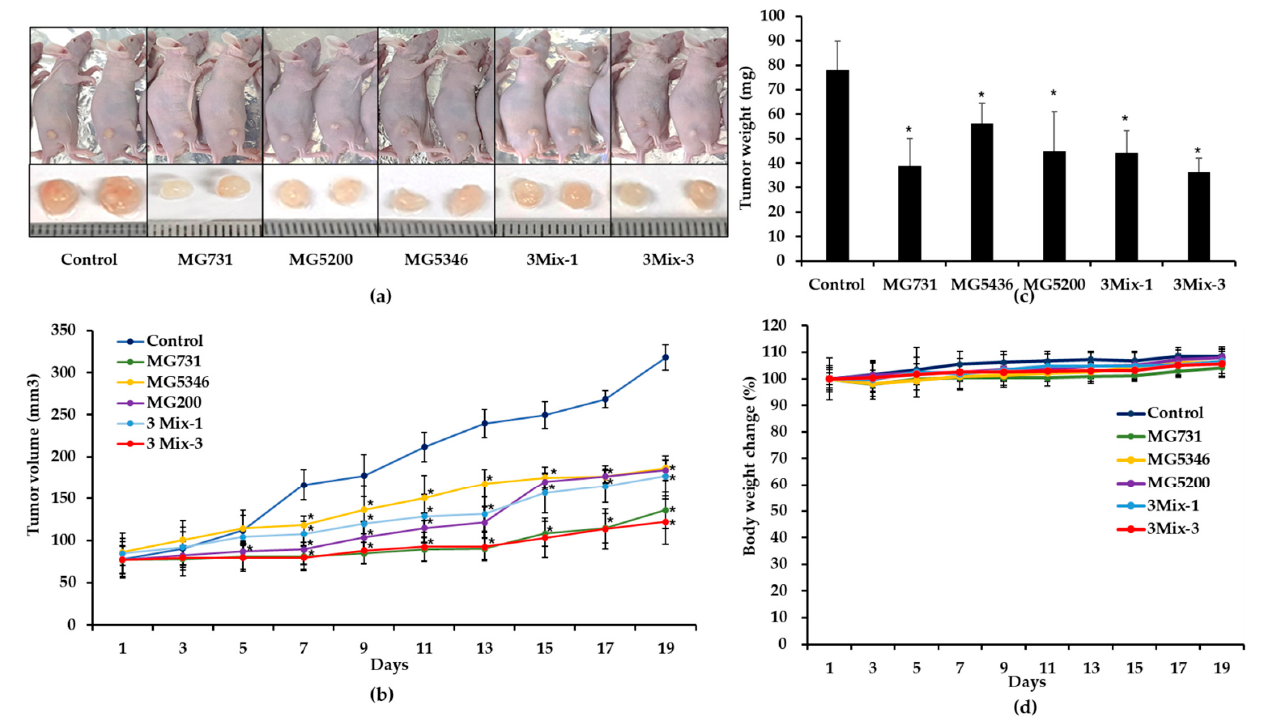
Figure 3. The tumor growth inhibitory effect of heat- killed Bifidobacterium and Lactobacillus in xenograft model implanted with human gastric cancer MKN1 cells. BALB/c nude mice were subcutaneously injected with 5 × 10 6 MKN1 cells/mouse into the dorsum next to right hind leg. The mice were orally administrated drinking water or a single or mixed strain of heat-killed bacterial strains every day for another 19 days. ( a ) Photographs represent tumor size of xenograft model mice. ( b ) Tumor growth curve. ( c ) Tumor weight (mg). ( d ) Body weight changes. Results are presented as the mean ± SD ( n = 6). * p < 0.05 compared with the control group. Control, drinking water; MG731, B. bifidum MG731 (1 × 10 9 cells/mouse); MG5346, L. reuteri MG5346 (1 × 10 9 cells/mouse); MG4584, L. rhamnosus MG5200 (1 × 10 9 cells/mouse); 3Mix-1, 1:1:1 mixture of B. bifidum MG731 + L. reuteri